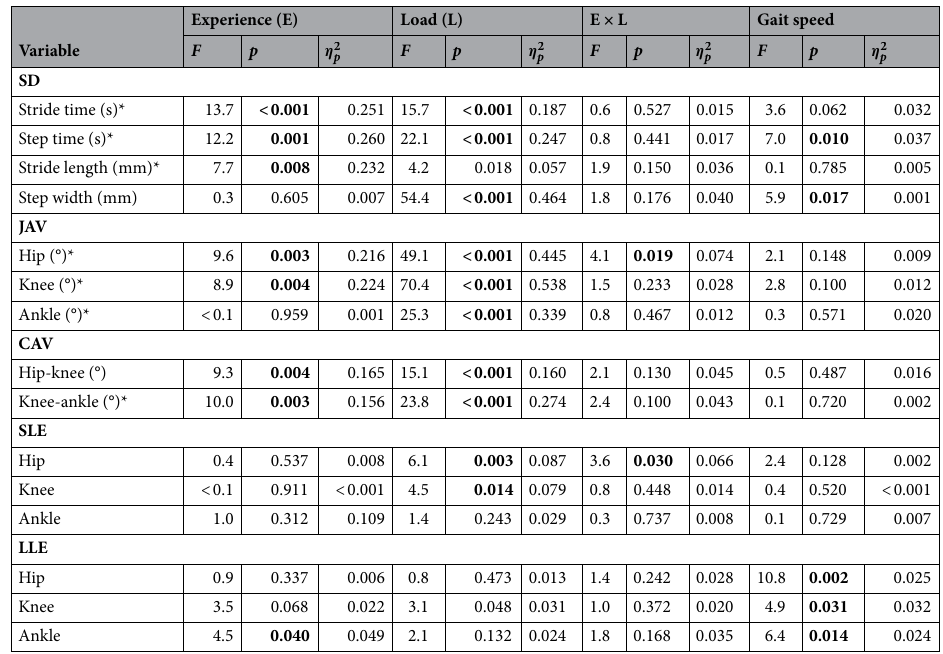
Table 5. Analysis of covariance results for measures of gait variability (GV). The table presents the F statistics, p- values, and effect sizes for the main effects of experience level (E: 1st-year vs. 4th-year) and load condition (L: Load Zero vs. Load Low vs. Load High ), and the interaction effect of experience level and load condition (E × L). The effect of the covariate (gait speed) is also included. Significant effects are highlighted in bold. When reporting p -values, if p -value was smaller than 1 in one thousand, instead of reporting the exact p -value up to the first significant decimal figure, we followed standard statistical abbreviation and reported it as p < 0.001.